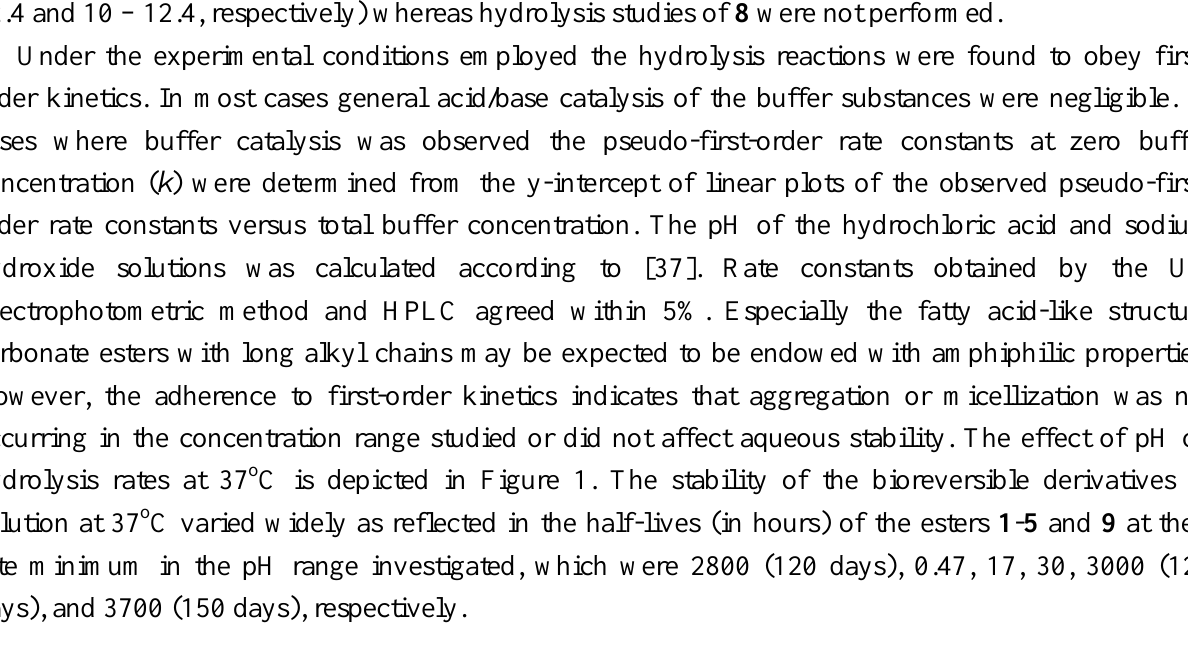
Figure 1. pH-rate profiles for the hydrolysis of compounds 1 ( (cid:85) ), 2 ( (cid:86) ), 3 ( (cid:132) ), 4 ( (cid:122) ), 5 ( (cid:173) ), and 9 ( (cid:123) ) in aqueous solution at 37 o C ( μ = 0.50